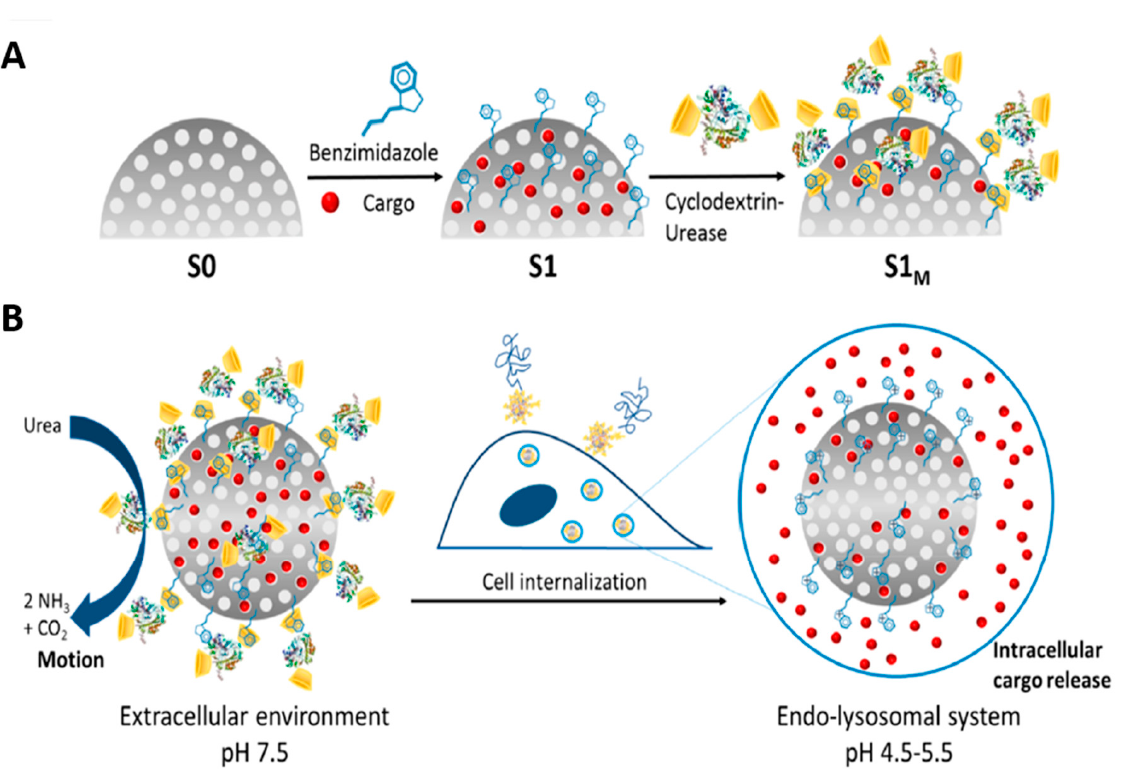
Figure 5. The development ( A ) and working ( B ) of the enzyme-powered stimuli-responsive na- nomotors. Reproduced from Lopis-Lorente et al. [90], Open Access.